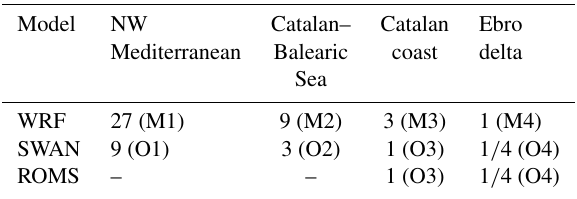
Table 1. Resolution (in km) of the different domains/meshes used in the nested system as a function of each numerical model and regional scale covered. In parentheses the mesh name in Fig. 1 is